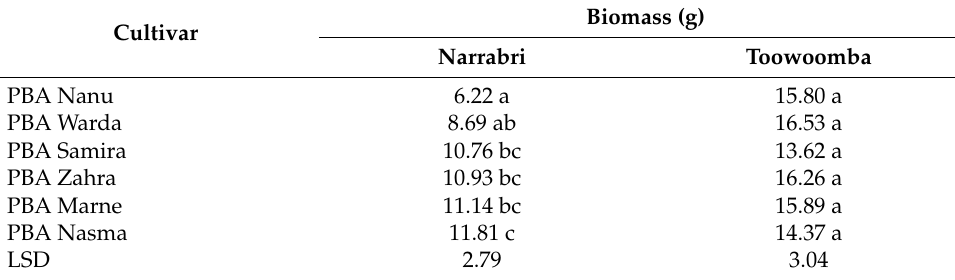
Table 3. Dry biomass (g) of different faba bean cultivars grown in Narrabri and Toowoomba. Means with a different letter are significantly different at p -value ( α =